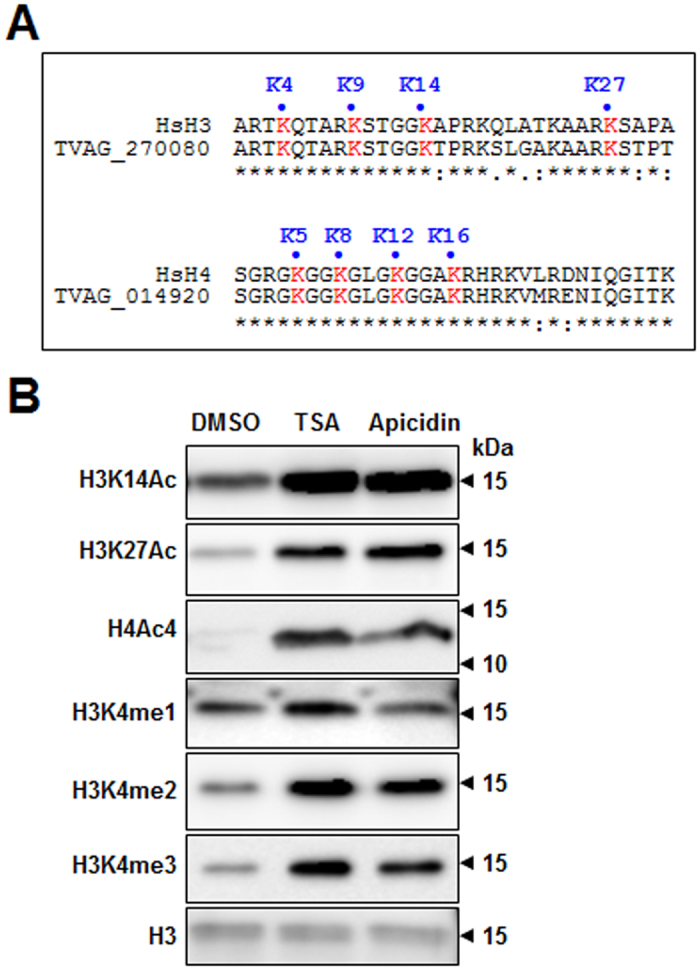
Histone modifications conferred by stimulation with HDAC inhibitors in T. vaginalis.(A) Identification of epigenetic marks in T. vaginalis. Alignment of the H3 and H4 N-termini for Homo sapiens (Hs) and T. vaginalis (Tv). (*) identical residues; (.) and (:) weakly and strongly similar residues, respectively. (B) T. vaginalis cells were treated with DMSO (0.1%), TSA (1 μM), or apicidin (70 nM). Protein samples collected at 4 hours post treatment were analyzed by SDS-PAGE. The H3K14Ac, H3K27Ac, H4Ac4, H3K4me1, H3K4me2, and H3K4me3 sites were detected by immunodetection. Total histone H3 was used as a loading control. Molecular weights are shown in kDa. Blots shown have been cropped from full length blot. Full length blots are shown in Supplementary Fig. 9.